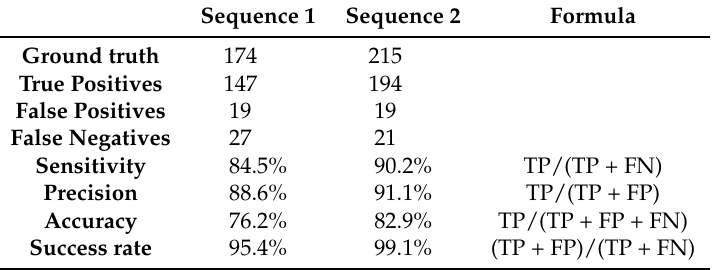
Table 2. Performance results for the two 5 min test